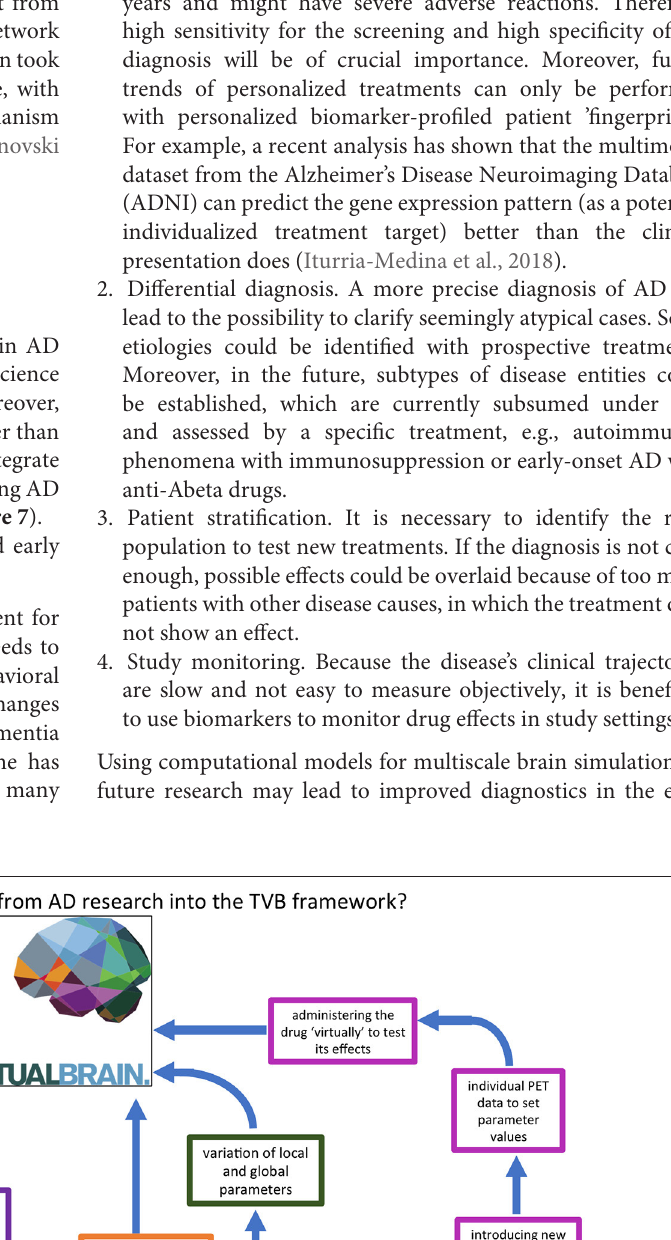
Frontiers in Neuroinformatics |